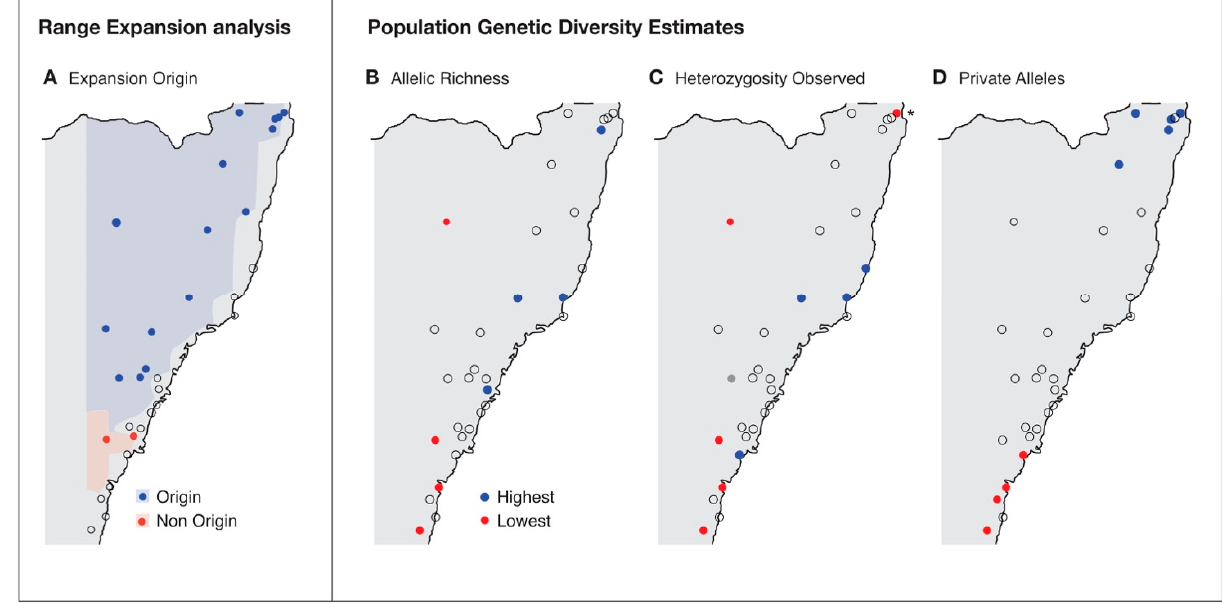
Figure 7. ( A ) Range expansion analysis; blue shows possible origin of expansion and red shows non-origin regions. ( B – D ) Population genetic diversity estimates (Table 2) mapped for Ficus coronata . The four highest results are shown in blue, the four lowest in red. ( B ) Population allelic richness ( A R ). ( C ) Heterozygosity observed ( H O ). * Population 02 in red at the northeast boundary is unexpectantly low, though the difference is only 0.001 between it and populations 29 and 30 at the southern boundary. ( D ) Private alleles ( P A ); the third highest value is the same for two sites.